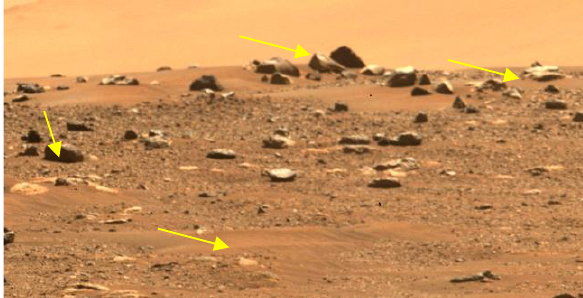
Figure 18. Mastcam-Z image recorded on Sol 4. Several big boulders can be